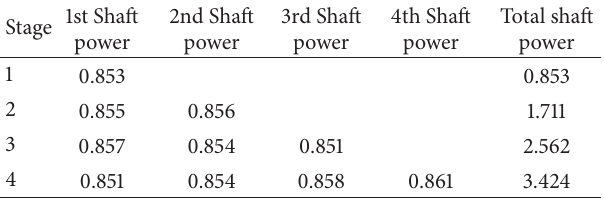
Table 5:Shaft power atdesignflowcontrastofdifferentstages (kW).